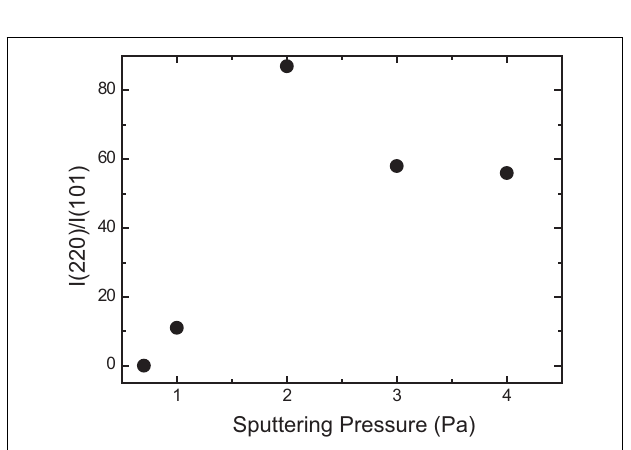
FIGURE 3 |The X-ray diffraction patterns ofTiO 2 thin films deposited onto ITO substrates at different sputtering pressures . ( • represents diffraction peaks from ITO substrate).